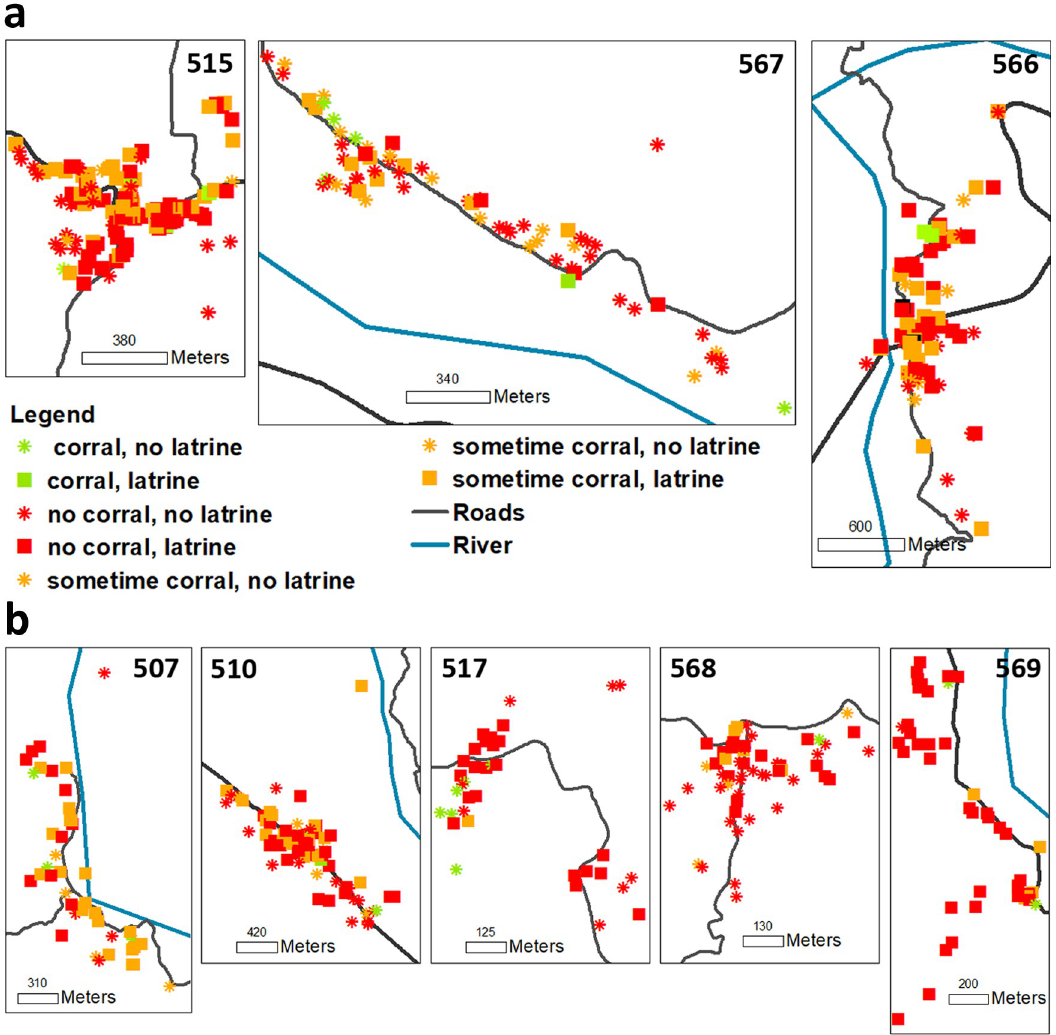
Fig 1. Simulated villages. Geographical distribution of households, use of corrals and latrine ownership in the villages that were used in the development of the model. Panel a : control villages used for model calibration. Panel b : intervention villages used for model